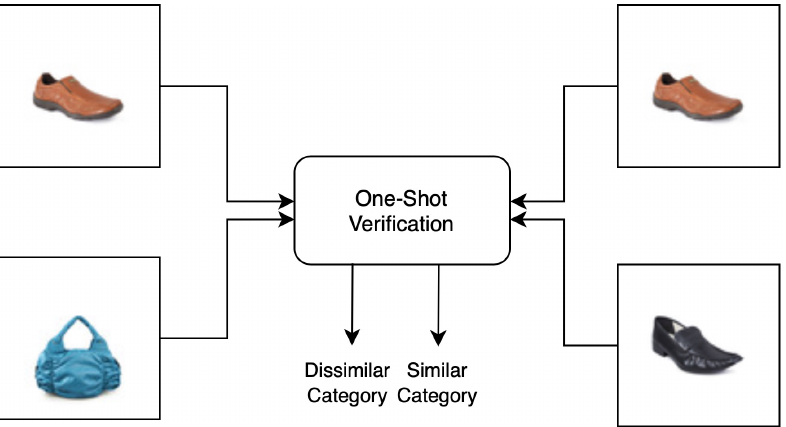
Figure 1. Visual representation of basic